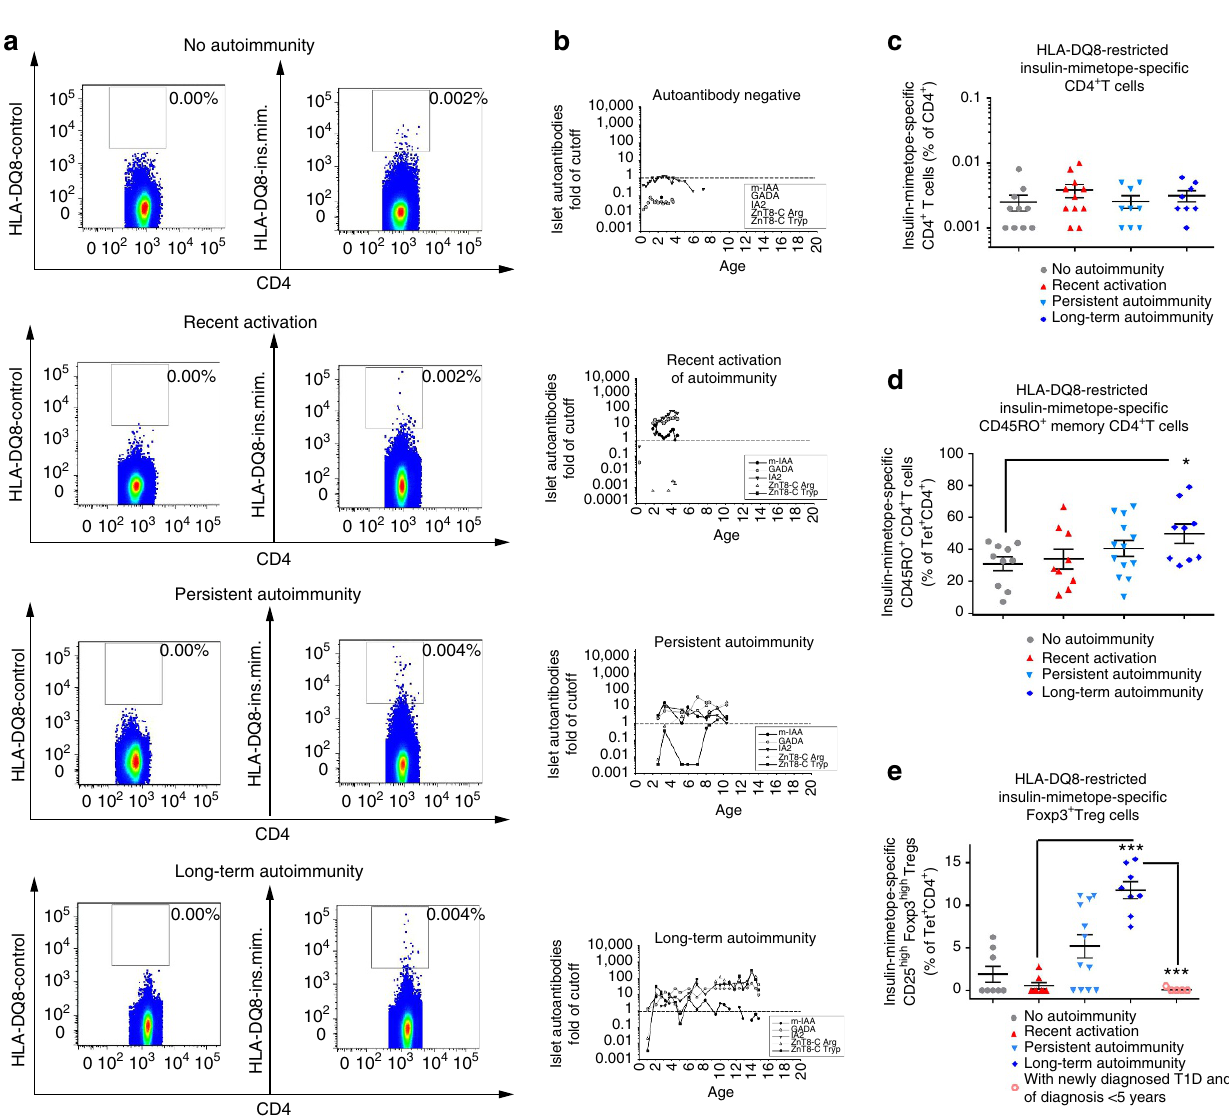
Figure 3 | Frequency of insulin mimetope-specific Foxp3 þ Tregs in children with recent onset of islet autoimmunity. ( a ) Representative set of FACS plots for the identification of HLA-DQ8-restricted insulin mimetope-specific CD4 þ Tcells with control (left) and insulin mimetope-specific tetramer (right) staining using CD4 þ T cells purified from HLA-DQ8 þ children without autoimmunity (islet autoantibody negative), with recent onset of